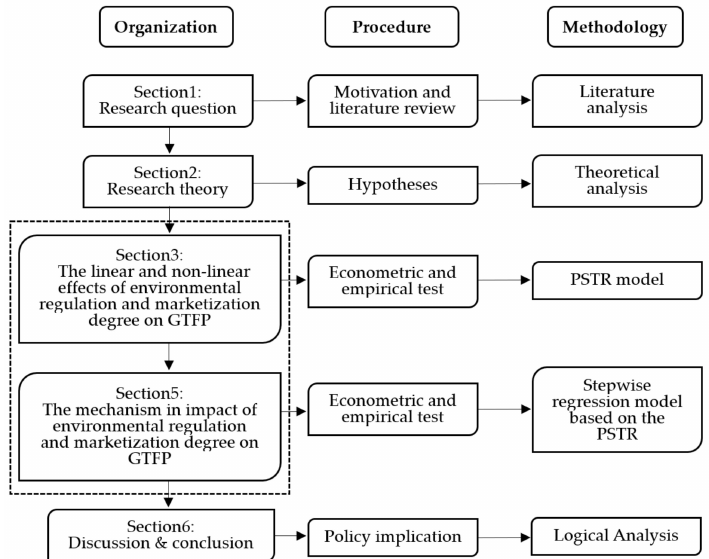
Figure 1. Methodological